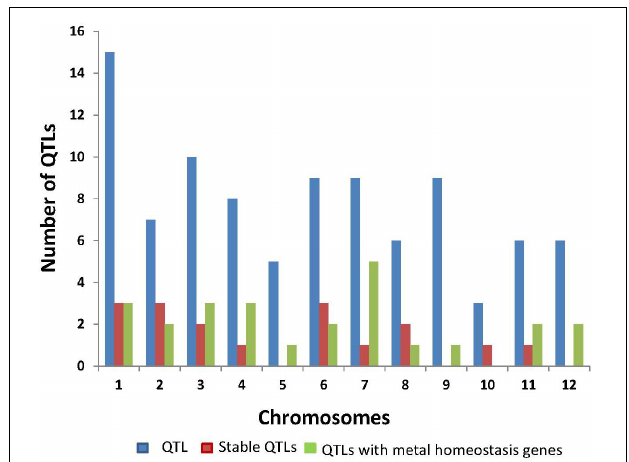
FIGURE 1 | Summary of Fe QTLs and genes reported from different studies in